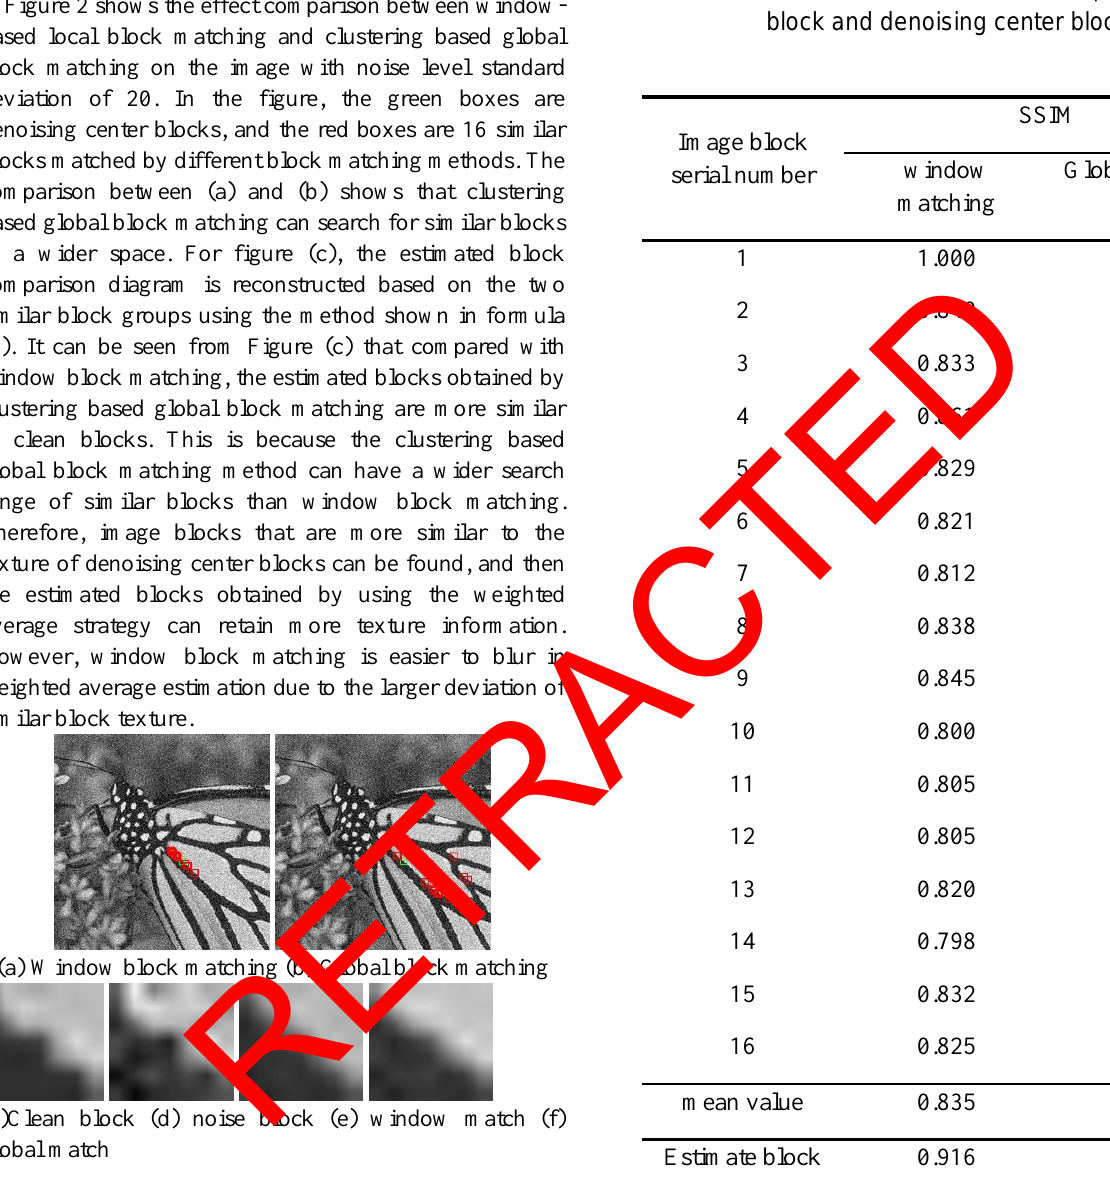
Table 1. SSIM values of similar